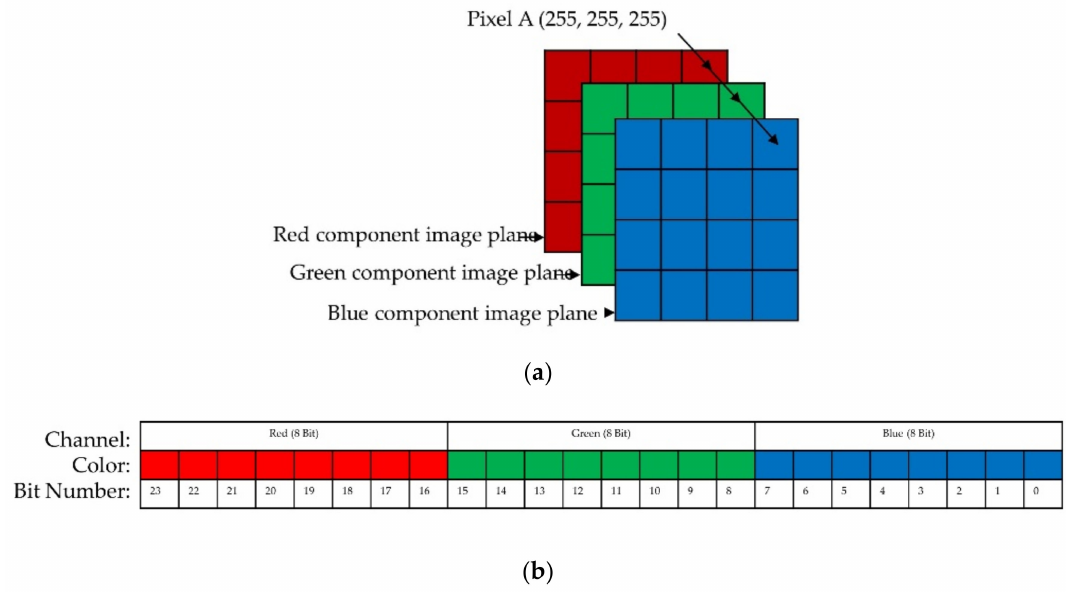
Figure 3. RGB representation of the smartphone image. ( a ) Red, green, and blue planes of the RGB image. ( b ) Bit representation of the RGB